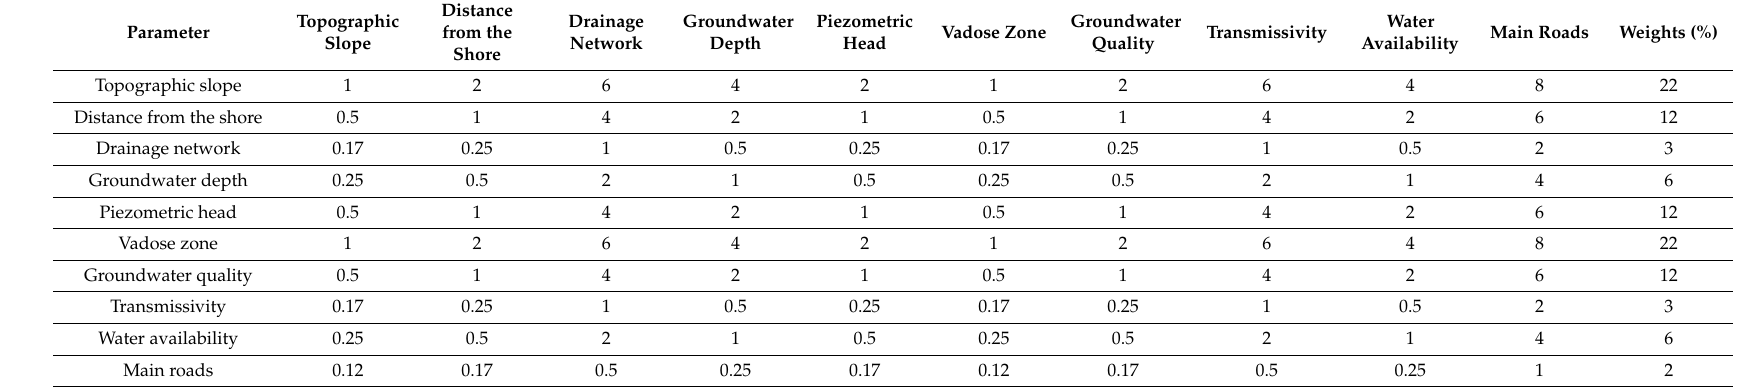
Table 3. Pair wise comparison of the parameters included in the site selection for MAR